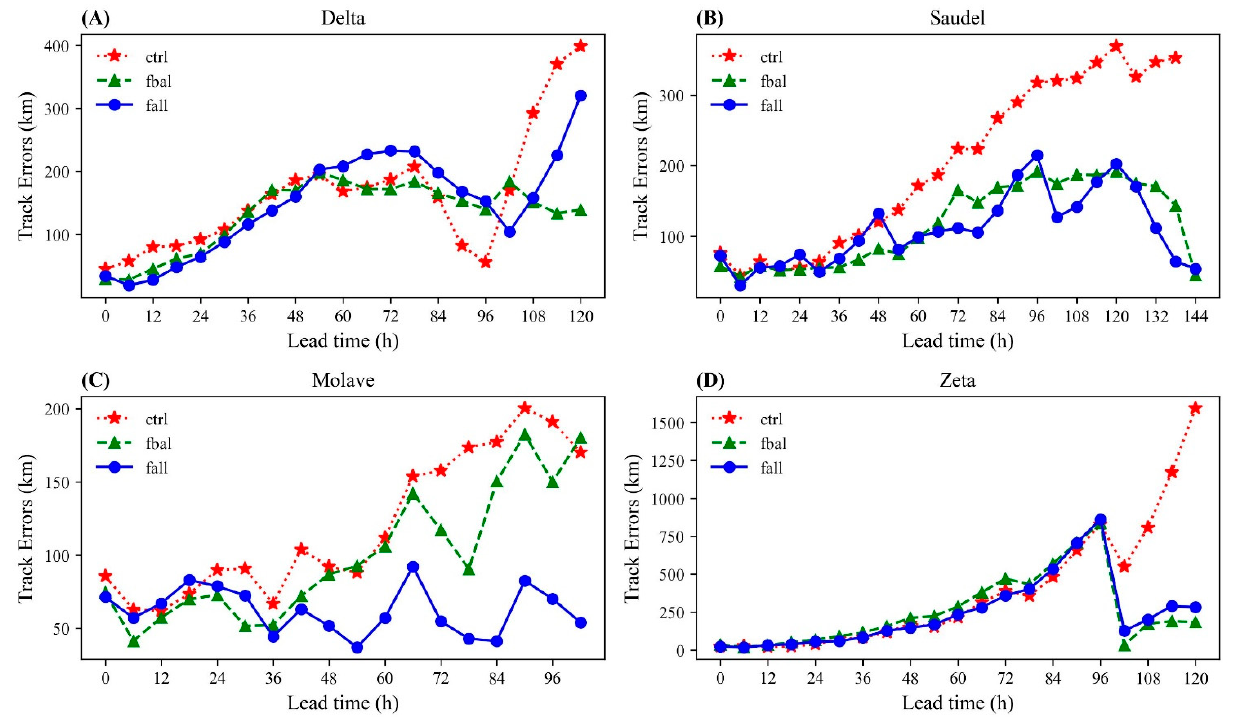
Figure 9. Track errors of Delta ( A ), Saudel ( B ), Molave ( C ), and Zeta ( D ) averaged for different initial forecast times.